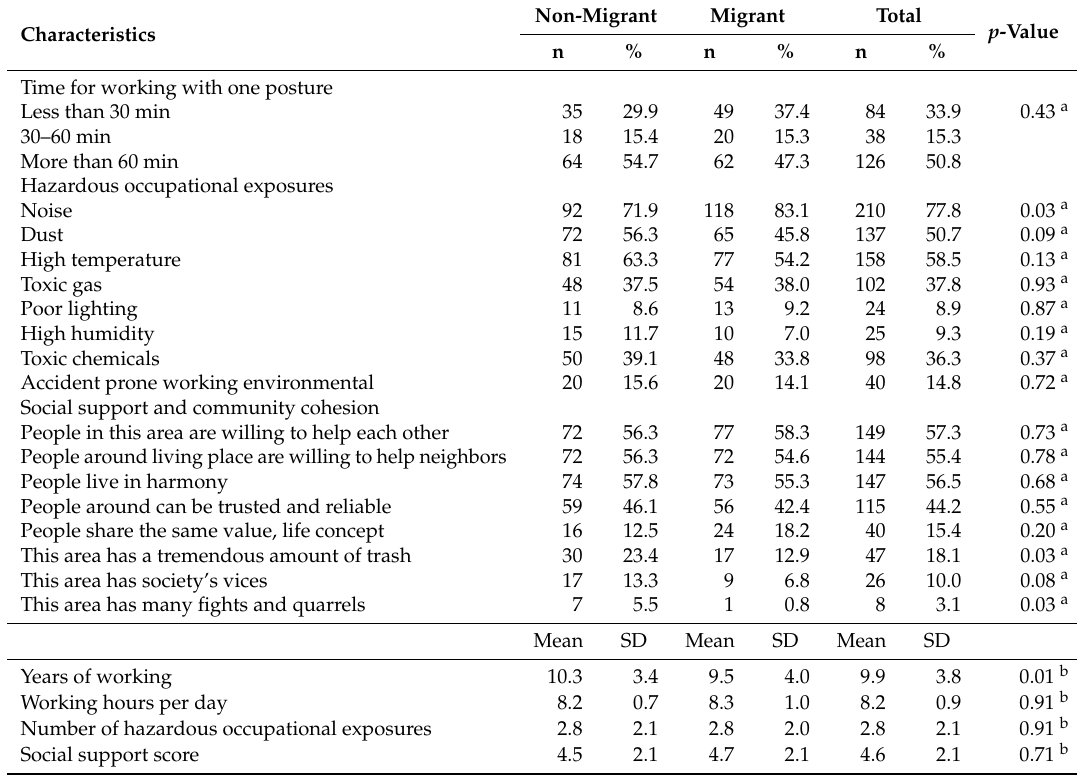
Table 2. Working and social environment factors.